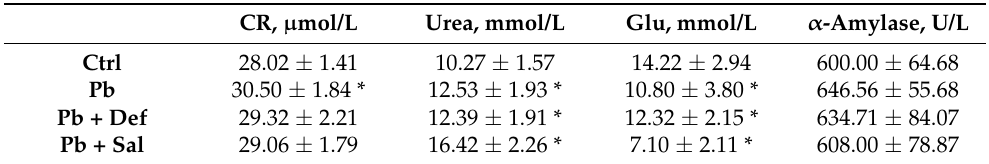
Table 2. Comparative effect of deferiprone and salinomycin on some biochemical markers in lead- exposed mice, n = 10. CR, µ mol/L Urea, mmol/L